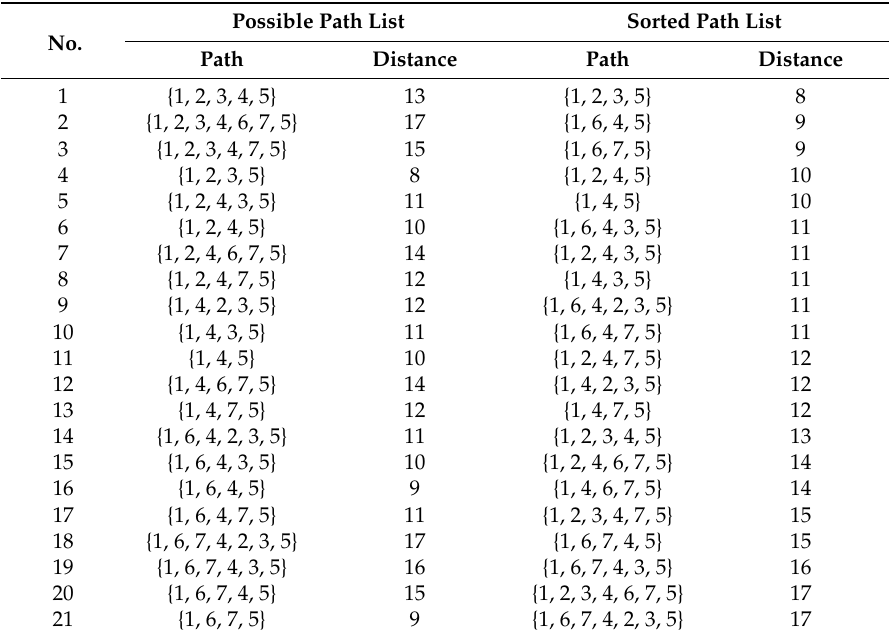
Table 1. Lists of all possible paths and sorted paths from source 1 to destination 5.